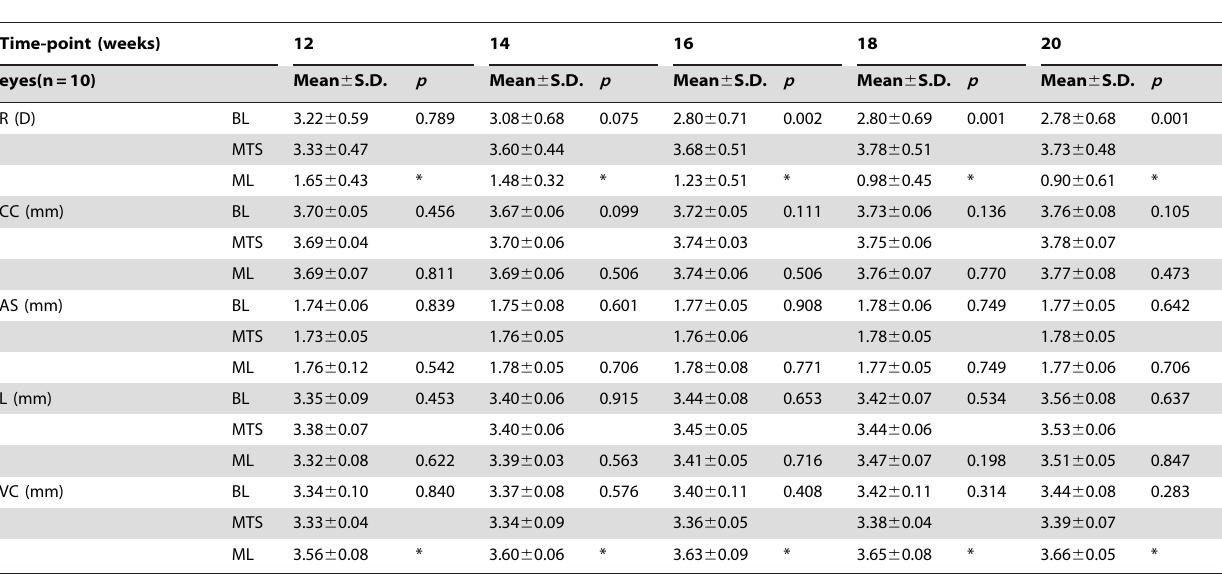
Table 3. Mean biometric results from guinea pigs reared in the three groups and the comparisons between the ML or BL and the MTS groups at each time point from 12 to 20